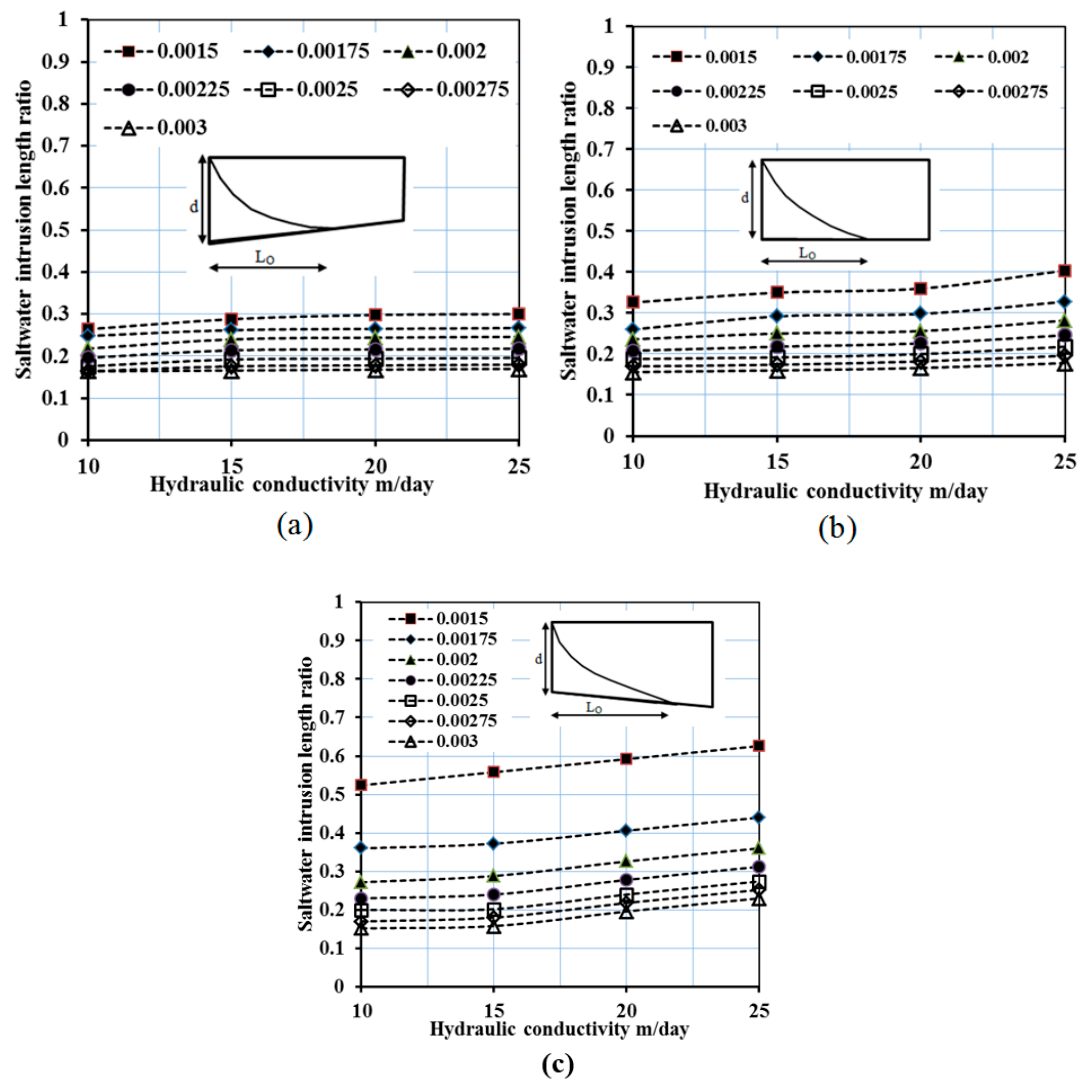
Figure 4. Relationship between hydraulic conductivity and SWI length ratio for tan β : ( a ) tan β = 0.02, ( b ) tan β = 0.0, and ( c ) tan β = − 0.02.